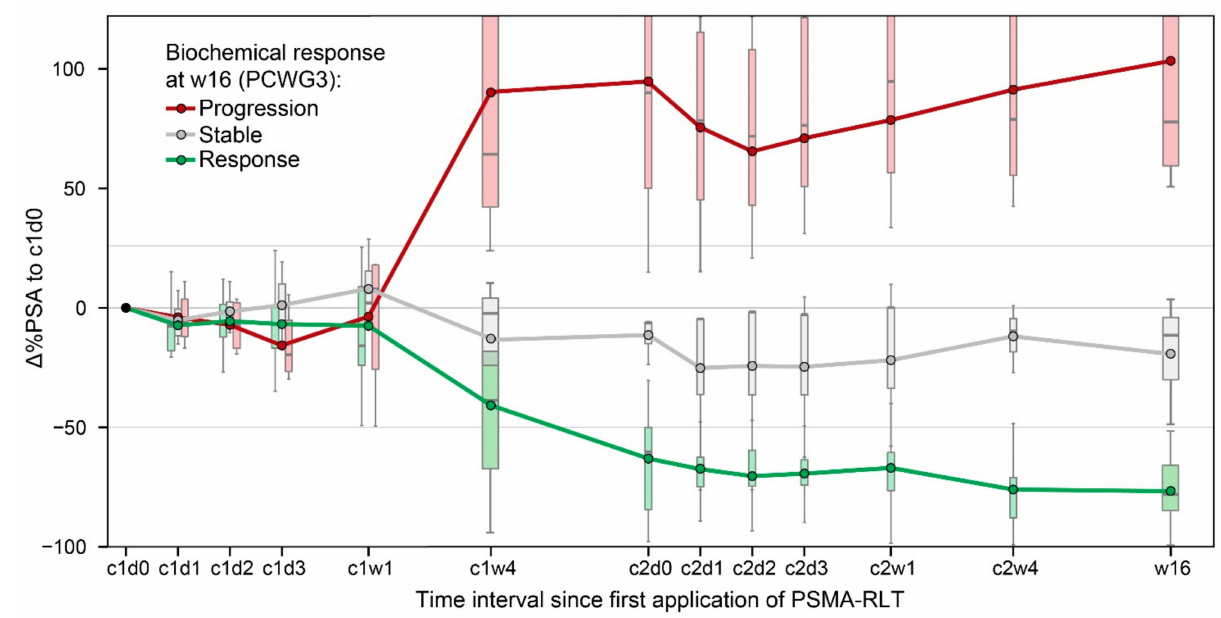
Figure 2. Percental change in PSA ( ∆ %PSA) one day (c1d1), two days (c1d2), three days (c1d3), one week (c1w4) and at restaging 16 weeks (w16) after first administration (c1d0) of 177 Lu-labelled radioligand therapy (PSMA-RLT), categorized by the biochemical response at w16 following PCWG3 criteria. Response: PSA decrease of at least 50%, Stable: PSA decrease smaller than 50% or PSA increase smaller than 25% and Progression: PSA increase of at least 25%. Mean values (open circles), and box plots are given for each time point.